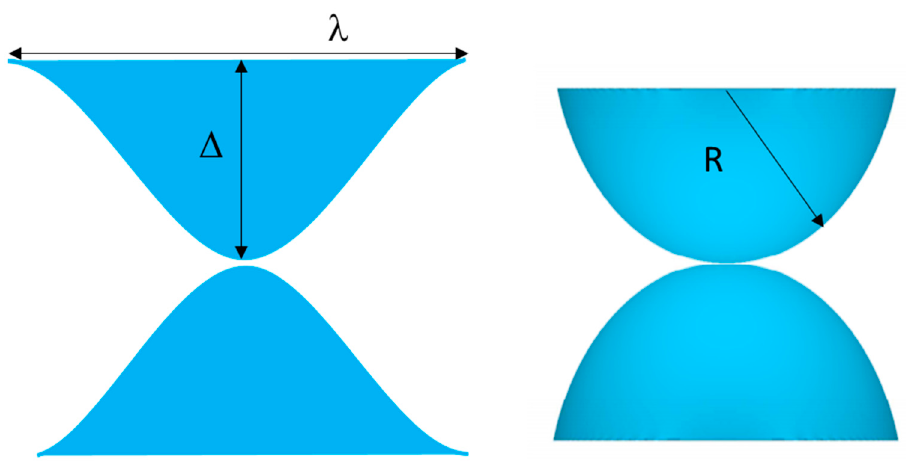
Figure 1. Geometry of sinusoidal and spherical asperity contacts compared.